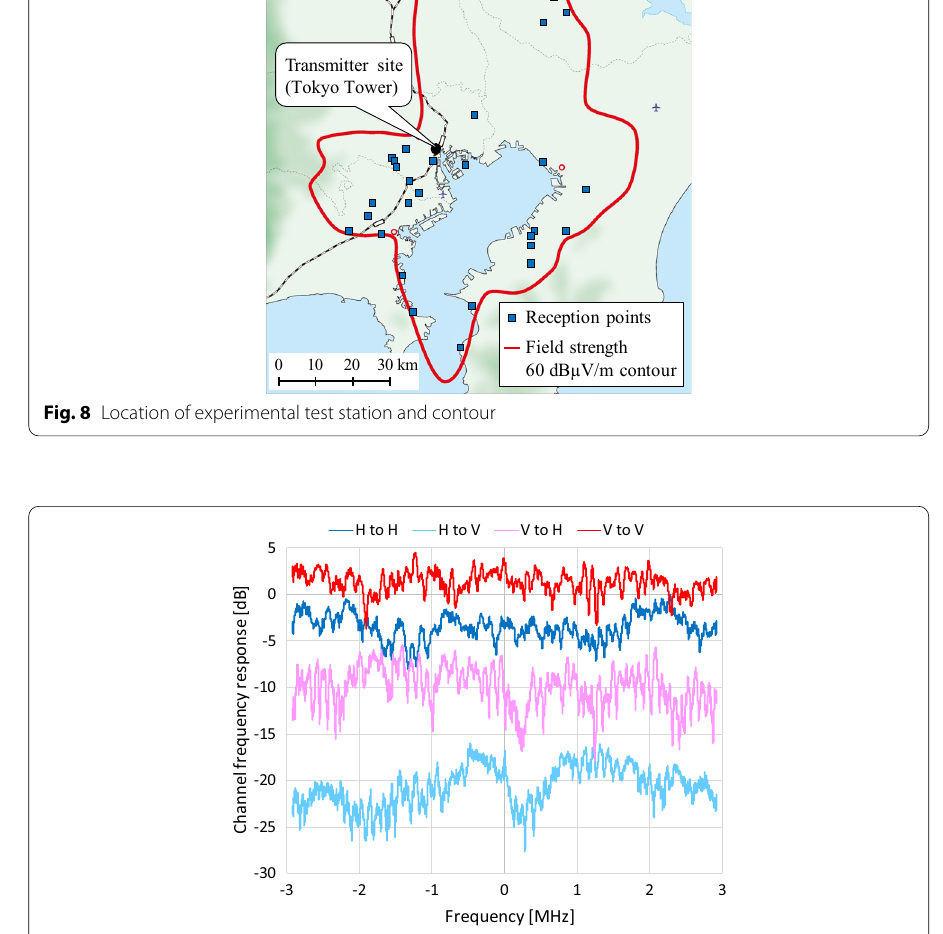
Fig. 9 Example of MIMO channel frequency responses captured in field